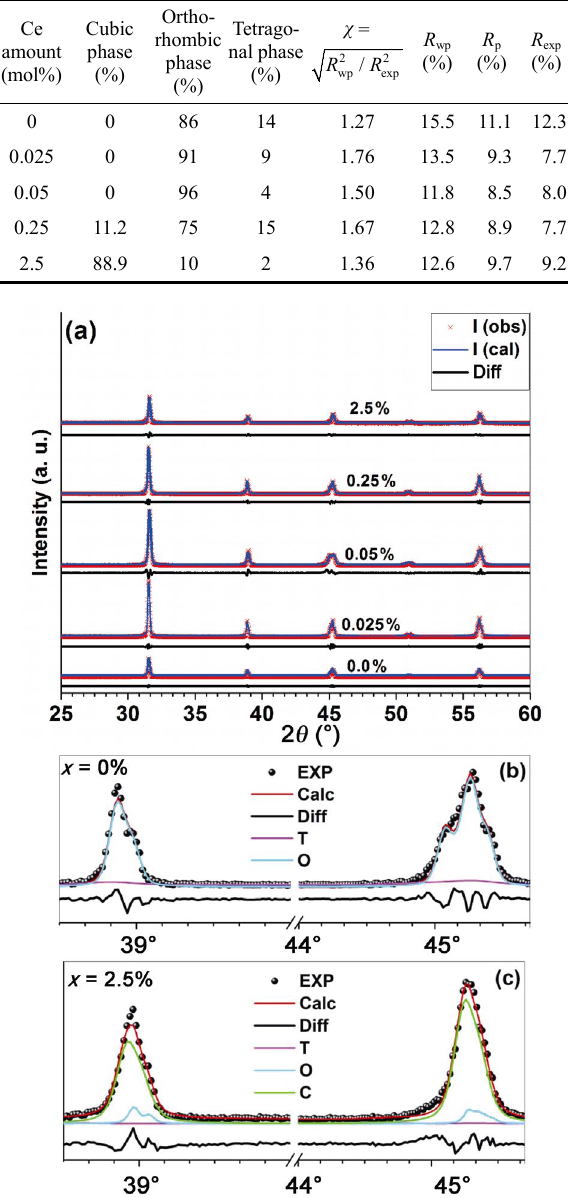
Table 1 Summary of the phase analysis obtained by Rietveld refinement for sintered Ce-doped BCZT samples